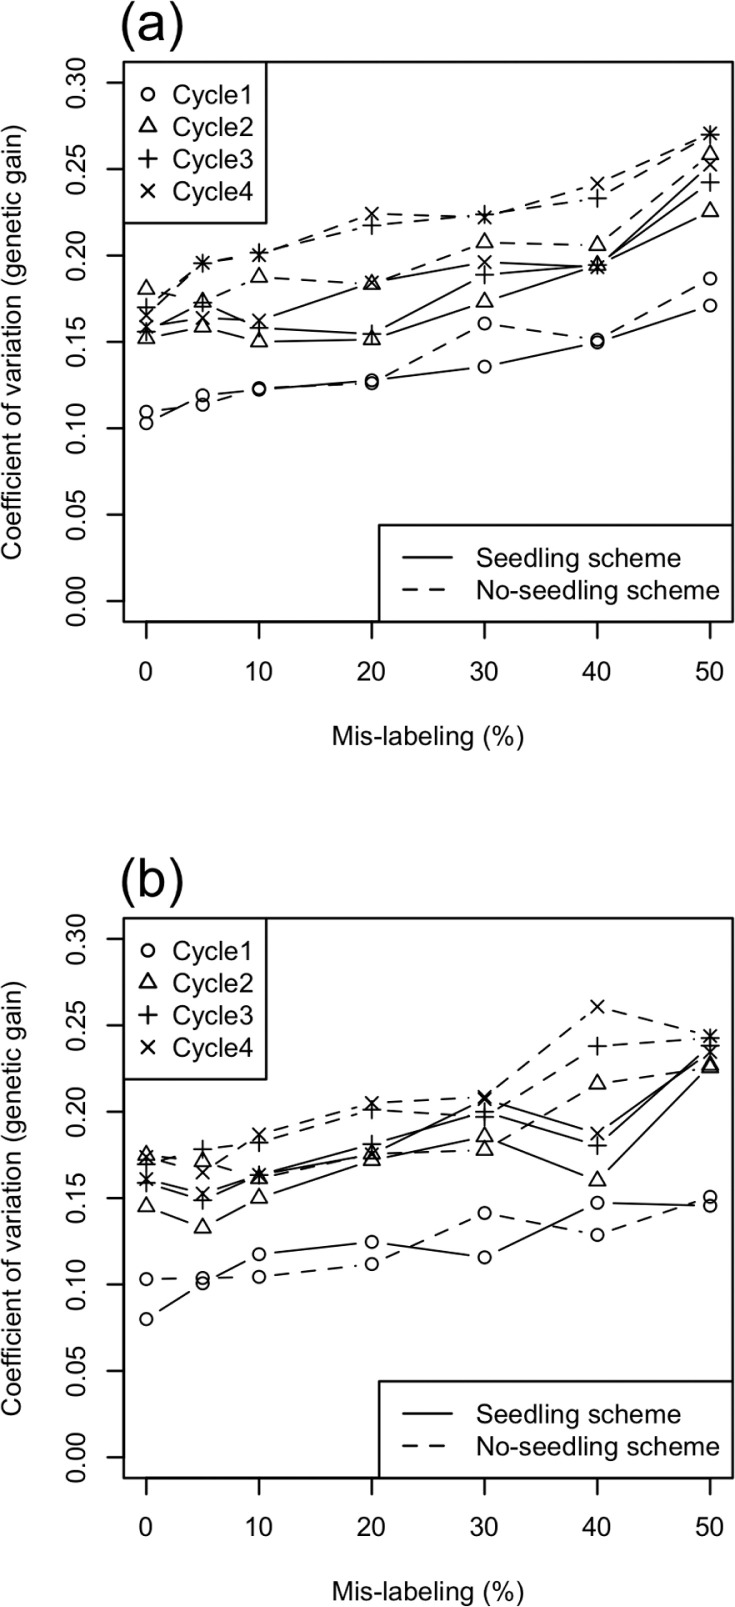
Coefficient of variation of genetic gain among 100 simulations with (a) source errors vs. (b) substitution errors. Symbols indicate different genomic selection cycles. Solid and dashed lines indicate seedling and no-seedling schemes, respectively.